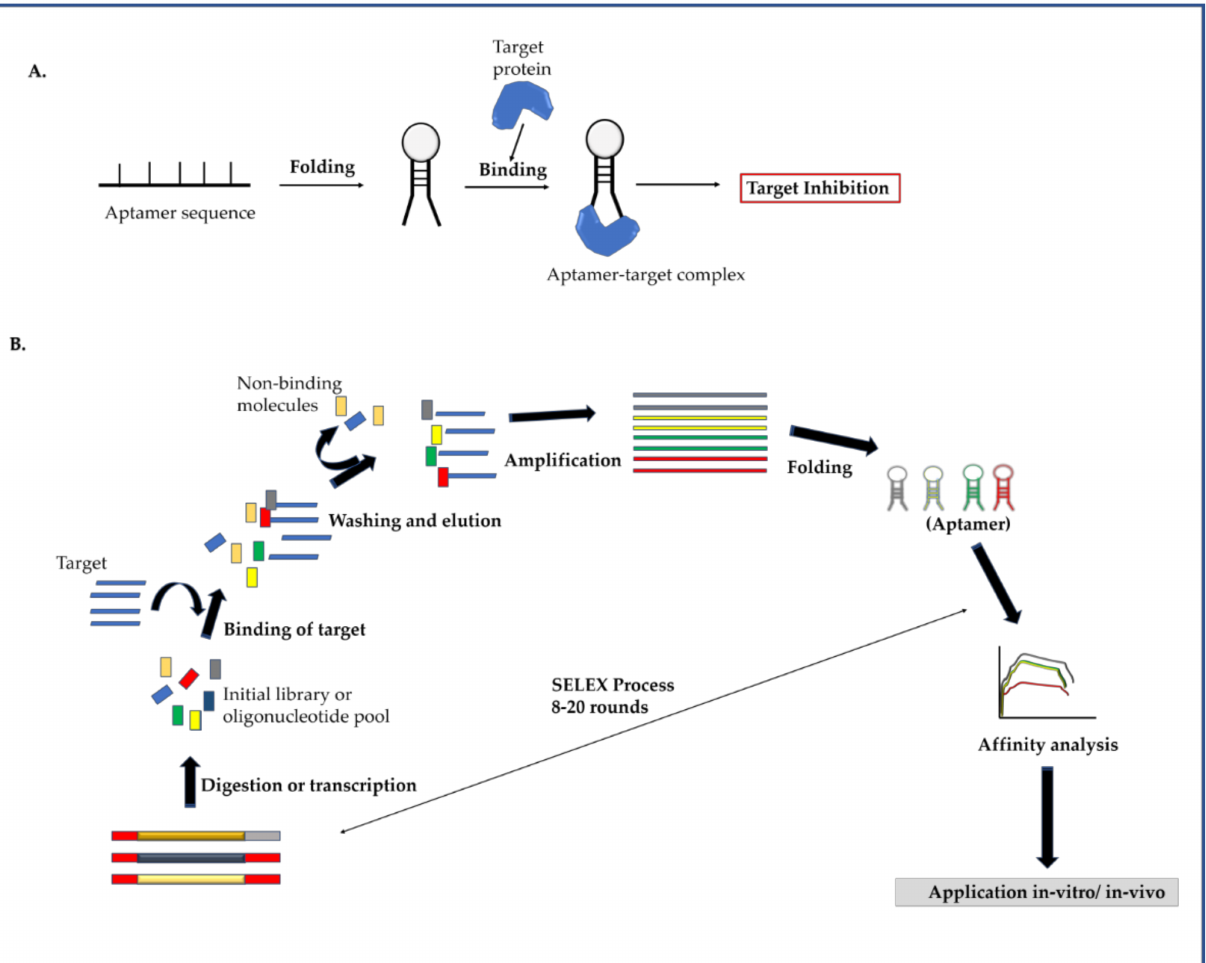
Figure 5. Aptamer as an antiviral. ( A ) The diagram showing schematic representation of aptamer binding towards a target. The aptamer folded itself in a 3D configuration after adjustment in a suitable condition. The target binds with the folded aptamer and forms an aptamer target complex and resulting in target inhibition. ( B ) Schematic illustration of aptamer selection by SELEX technology. The screening cycle starts with incubating target molecules with the oligonucleotide pool. After washing of non-binding molecules, the bound molecules were amplified and analyzed for binding affinity. The cycle continues for 8–20 rounds for generating an effective aptamer